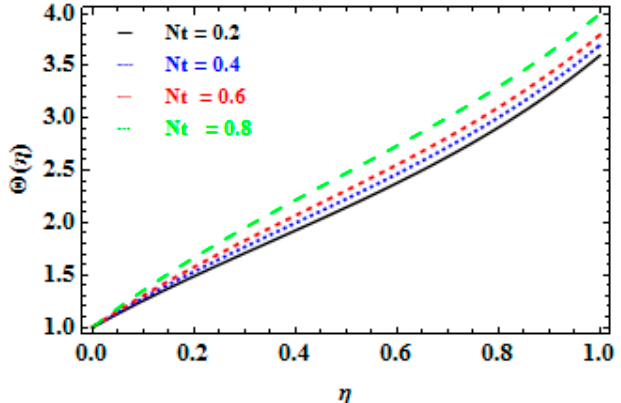
N on Θ ( 𝜂 ) . Figure 12. Influence of N Θ ( η ) . t on t